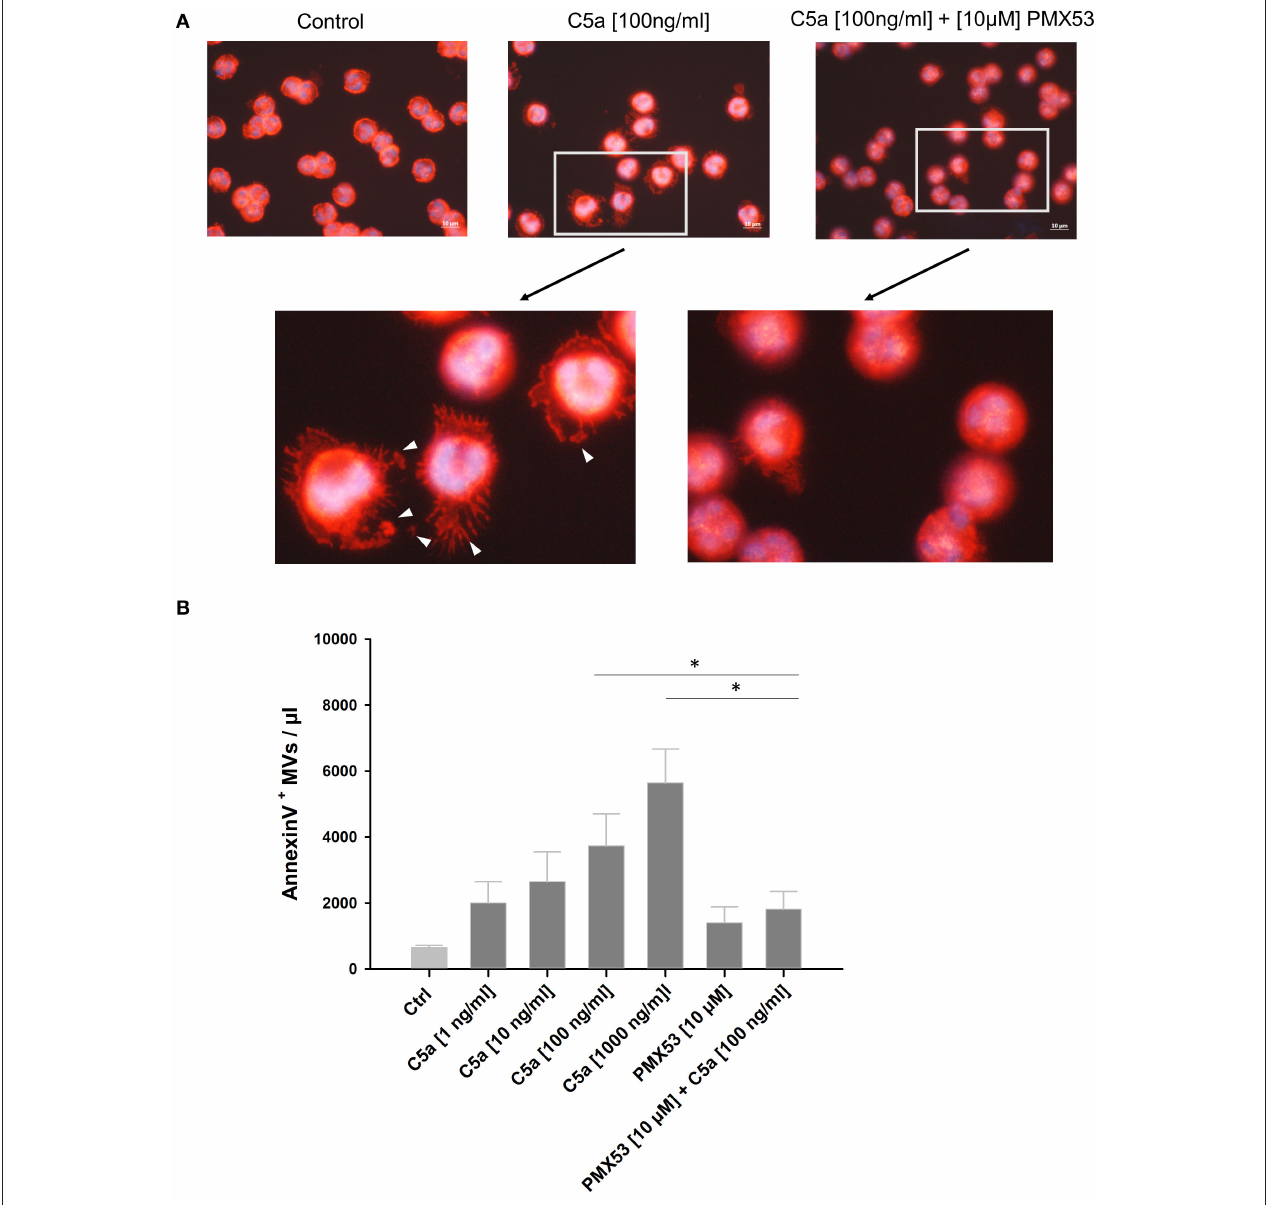
FIGURE 4 | Effect of the C5aR1-antagonist PMX53 on vesicle shedding. (A) Upper panel shows merged image of F-actin staining (red, Phalloidin-Alexa Flour 568) and nuclei staining (DAPI) of fixed PMNs, untreated, after treatment with native human C5a (100ng/ml), and C5a treatment in combination with PMX53 (10 µ M) for 1h, respectively at 630x magnification. Lower panel with further zoom-in on PMNs from the upper panel, white arrows indicate shed MVs. Experiment was repeated at least three times. (B) Quantitative analysis of shed MV at different C5a concentrations and in presence of the PMX53 together and alone in 10 µ l supernatant ( n = 3). * p <